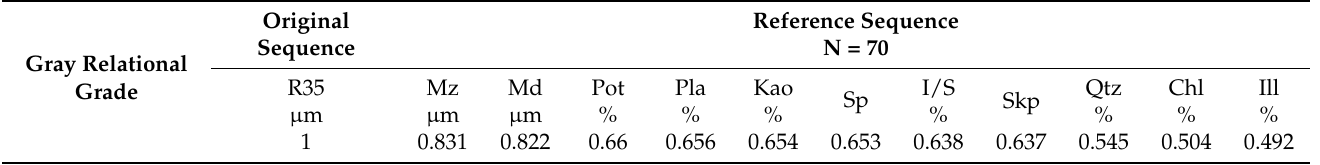
Table 7. Gray relational results